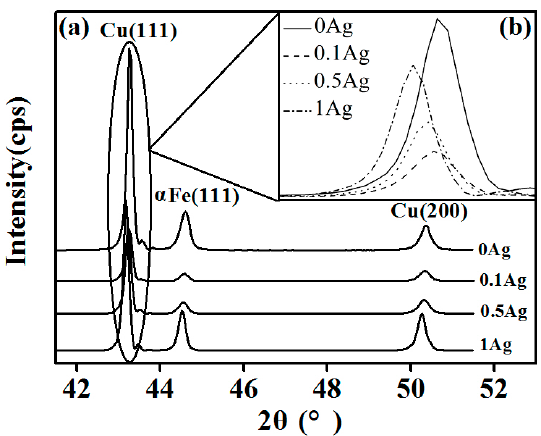
Figure 5. XRD spectra: ( a ) Cu–Fe–xAg alloy (x = 0, 0.1, 0.5, 1); ( b ) Cu(111) diffraction peak.